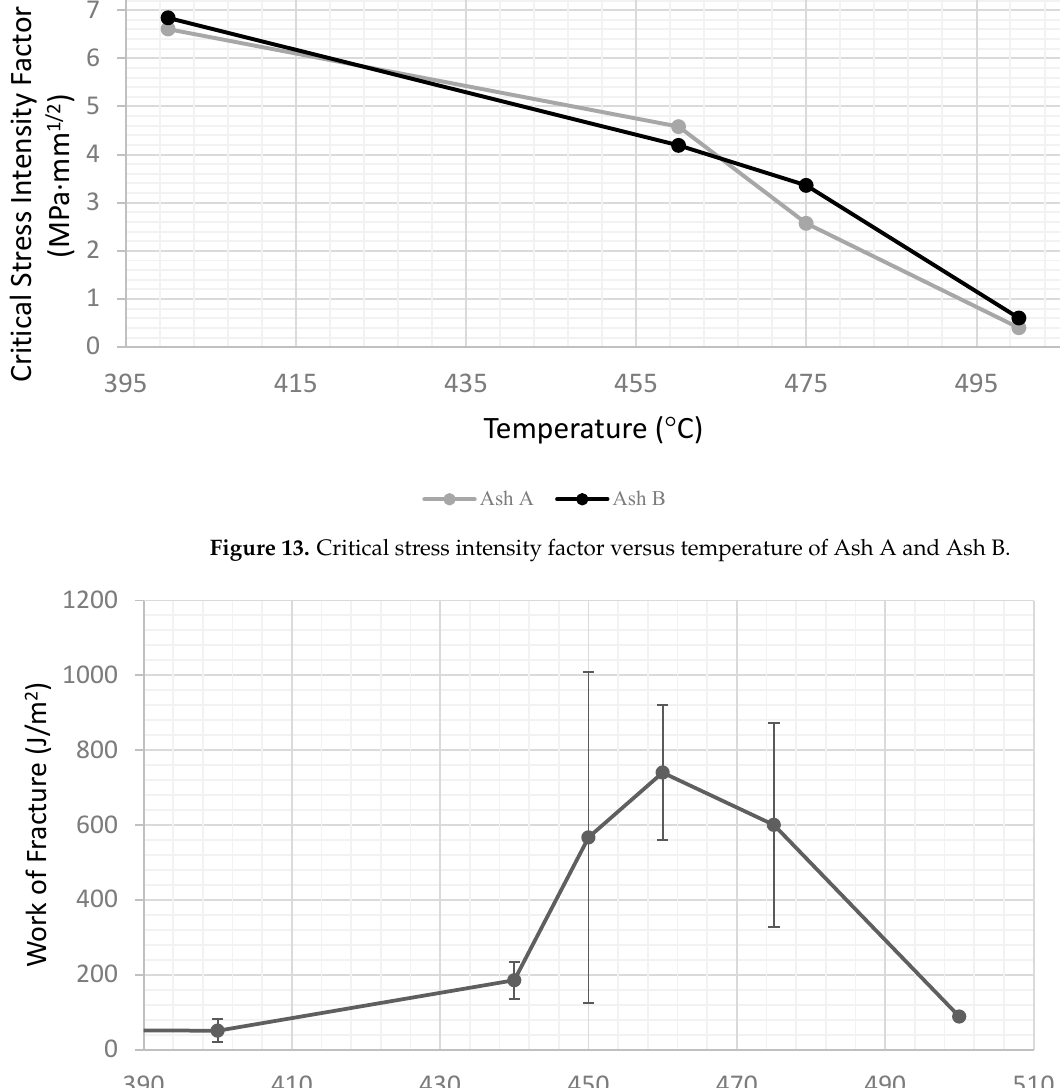
Figure 15. Critical strain energy release rate versus temperature for specimens tested at two different crosshead speeds. 6. Conclusions and Industrial Implications In critical sections of the recovery boiler, the back end of the superheater and front of the generating bank, the temperatures are such that tough boiler deposits form and are difficult to remove by sootblowing. The data presented here show that in the range of 450 °C to 500 °C, model deposits had a reduction in peak stress at failure but went through a maximum in their work of fracture, or capacity to absorb energy during cracking. At low temperatures (below 450 °C), the model deposits were relatively brittle, and this implies